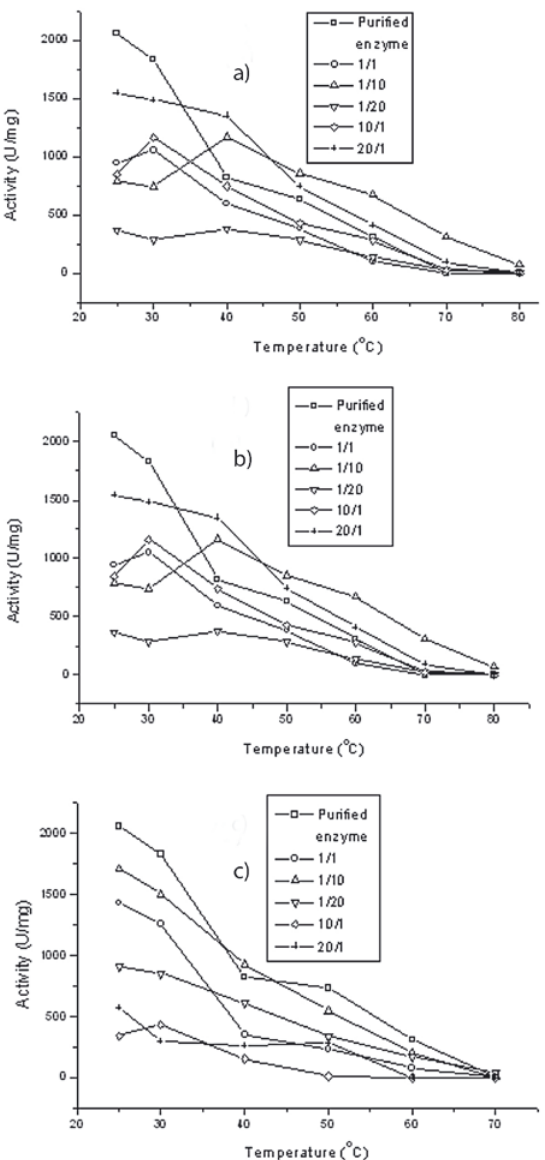
Figure 3. Thermal stabilities of HRP-dextran aldehyde conjugates /n 20, 10, 1, 1/10, 1/20) with different molar ratios (n HRP DA obtained using three different molar weighted dextrans at pH 7: a) with dextran 17 500 Da; b) with dextran 75 000 Da; /n 1/10) and HRP DA c) with dextran 188 000 Da; activity determination with 60 minutes incubation at working